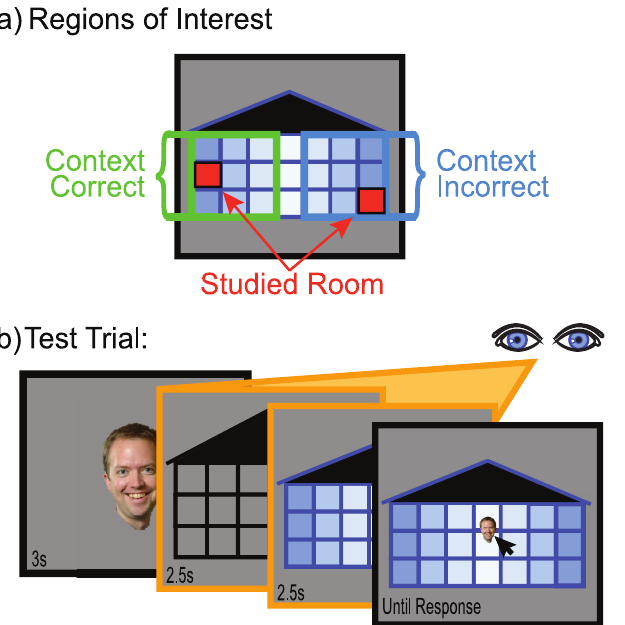
Fig 2. Design modifications used in Experiment 2. (a) General display information and resulting regions of interest. (b) Test phase design and timing information. Orange boxes indicate screens for which eye-tracking data was